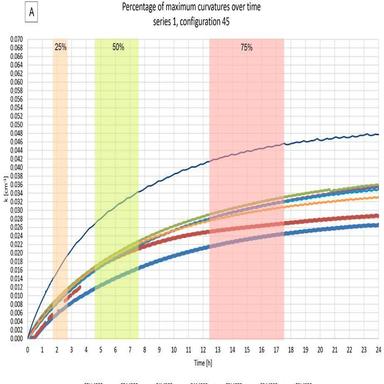
Different percentages of maximum curvature k over time of the first series, "configuration 45".